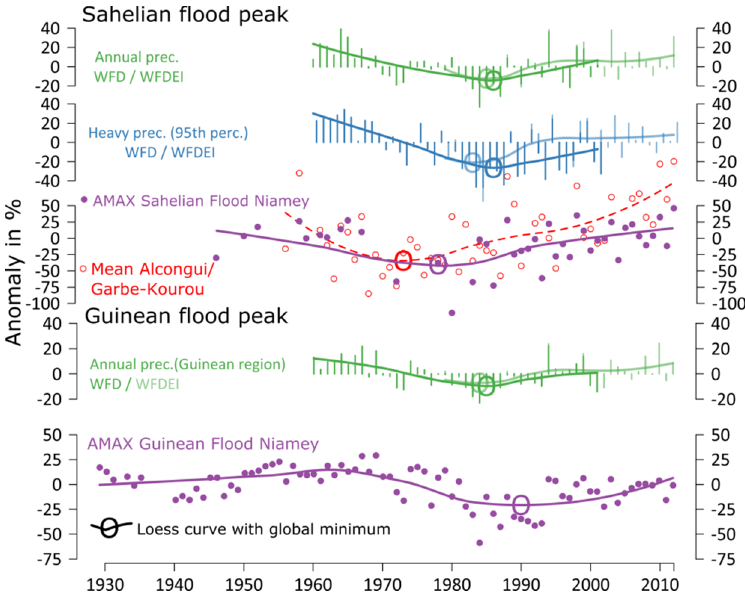
Figure 5. Sahel Paradox depicted with annual/ heavy precipitation from WFD and WFDEI and AMAX for the Sahelian flood peak at Niamey, and the mean of Alcongui and Garbe-Kourou. The AMAX of the Guinean flood peak at Niamey is depicted with the respective precipitation in order to illustrate the difference. All time series as anomalies in % with Loess curves and global minima. Table 1. Correlation of AMAX with heavy precipitation (95th percentile) and annual precipitation derived from WFDEI for the period from 1979–2012. All correlations are significant ( α = 0.05). Guinean Sahelian Benue Heavy precipitation